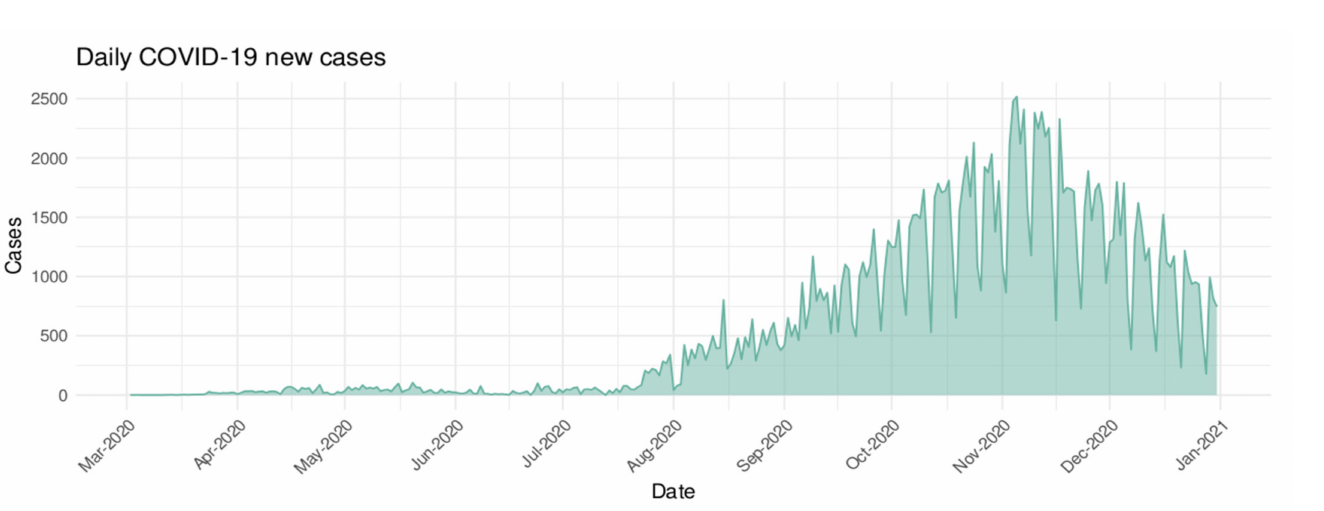
Figure 2. Time series distribution of daily COVID-19 confirmed cases in Casablanca region (from